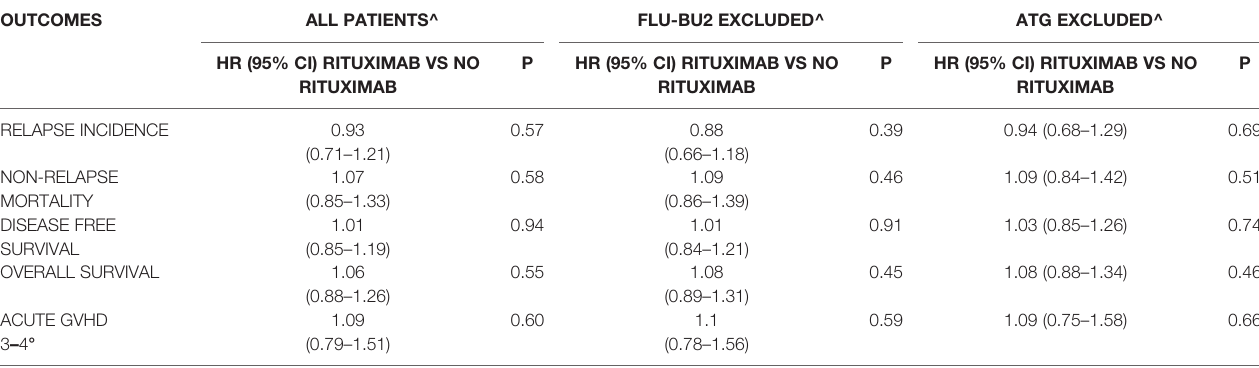
TABLE 3 | Transplant outcomes: strati fi ed by patients subsets.